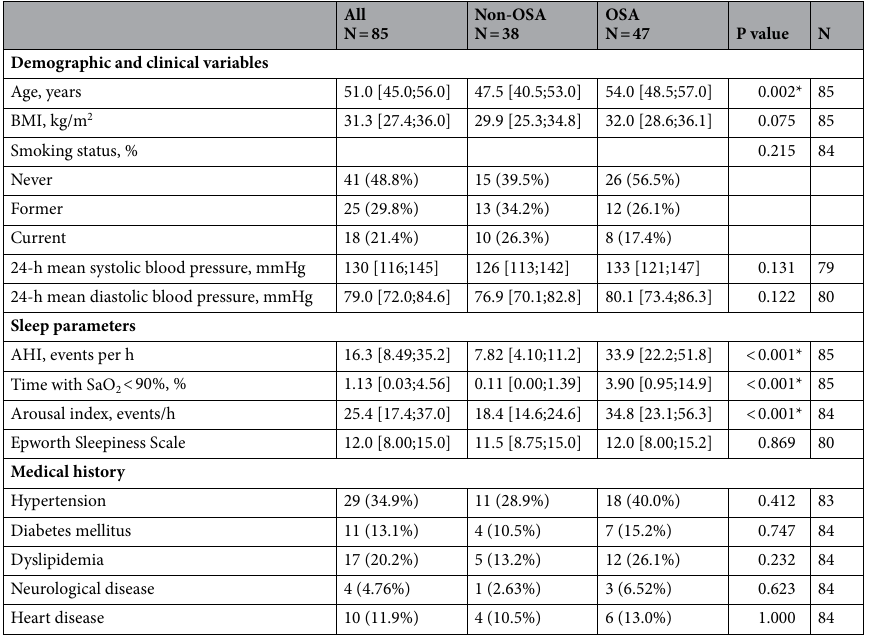
Table 1. Baseline characteristics of the patients. Data are shown as the n (%) and median [25th percentile; 75th percentile]. OSA, obstructive sleep apnea; BMI, Body Mass Index; AHI, Apnea–Hypopnea Index; SaO 2 , oxygen saturation. *Significant p values (p <